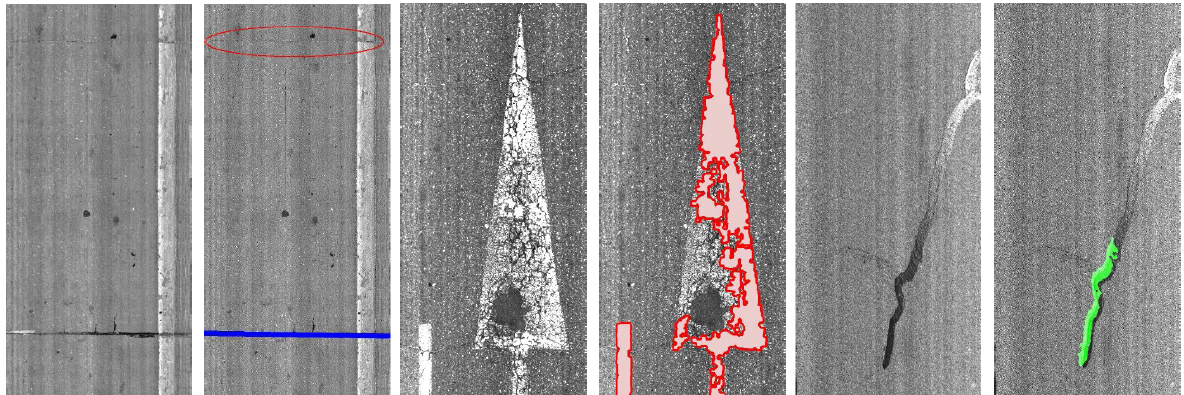
Figure 20. Non-crack false negatives. Left : not detected joint due to misalignment between images. Center : paint deterioration. Right : sealed crack not detected due to reflections.